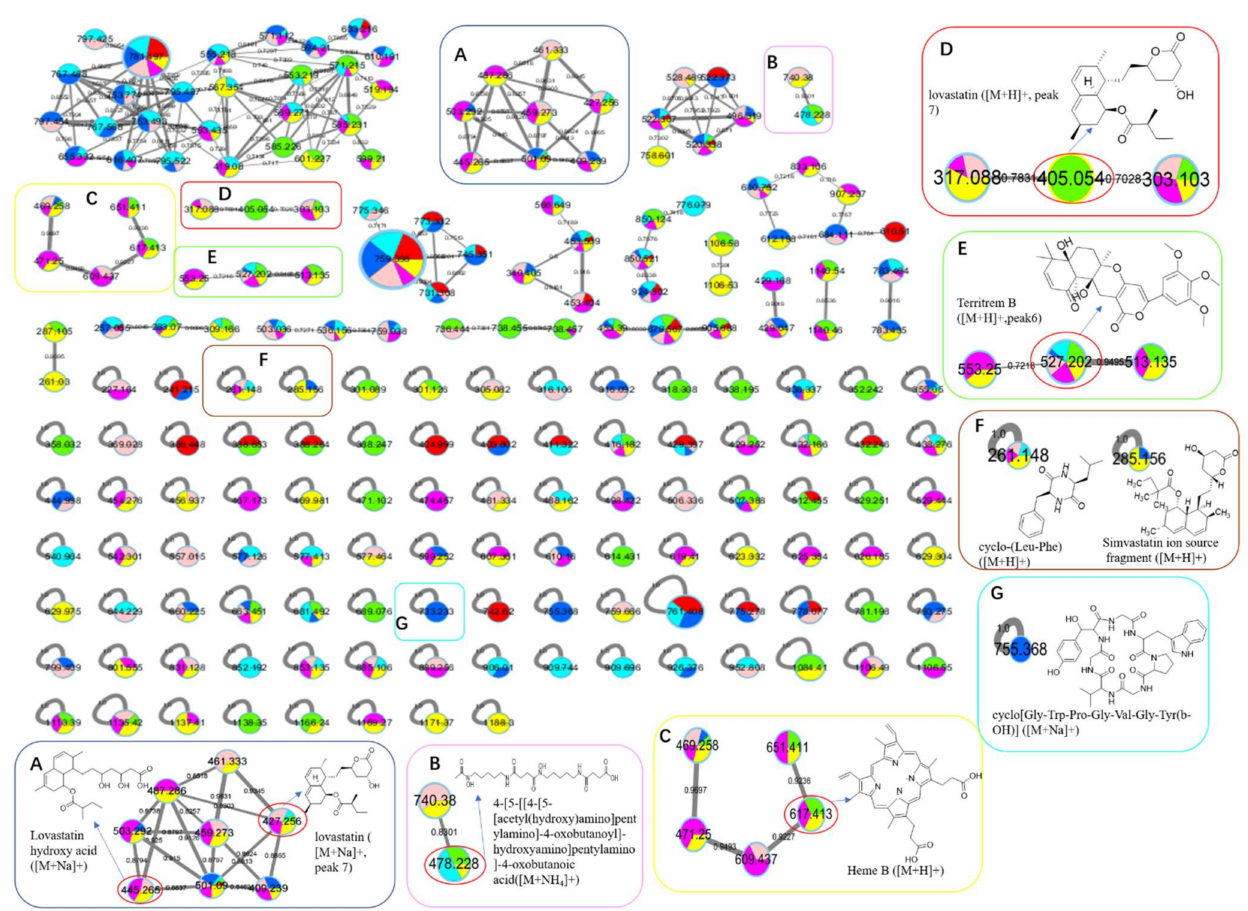
Figure 9. The GNPS molecular network based on positive ion MS/MS spectral similarity, showing a selection of amplified clusters. The nodes display the measured average masses of the molecular ions with identical MS/MS spectra. The sizes of the nodes reflect the relative amount of the corre- sponding compounds. The different colors of sections in the nodes represent different samples, i.e., : axU (G1), axT (G2), iacU-livT (G3), livU-livT (G4), livU/livT (G5),